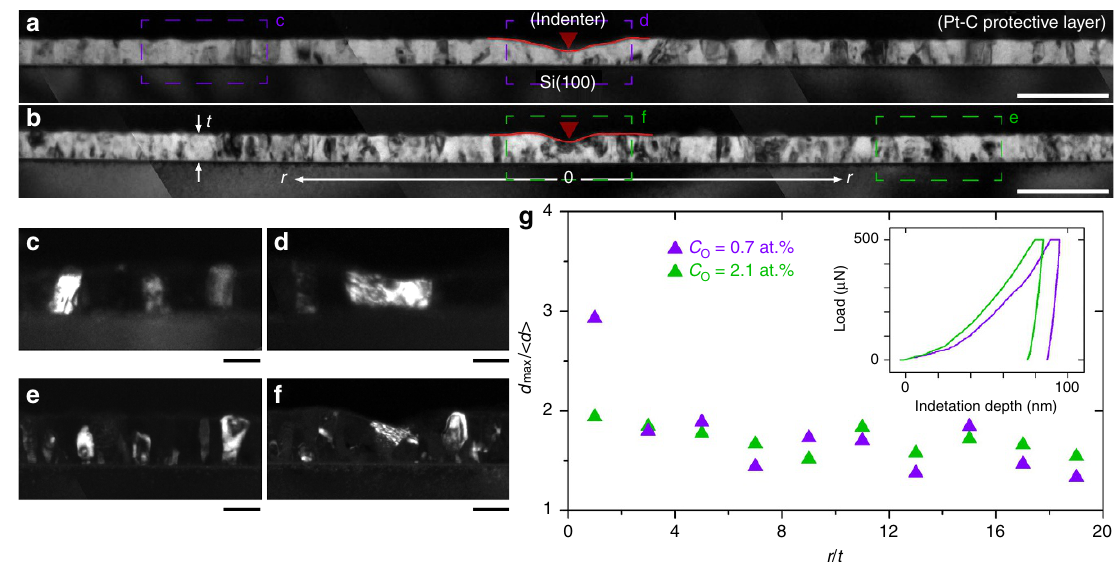
Figure 1 | Post-mortem observation of grain growth induced by nanoindentation and its suppression by impurities. ( a , b ) Bright-field TEM images of cross-sectional specimens extracted across indents in the NC Al films with global O content ( C O ) of ( a ) 0.7 and ( b ) 2.1at.%. Red lines show surface profiles of indents. Scale bars, 500nm. ( c – f ) Dark-field TEM images of individual grains ( c , e ) far from and ( d , f ) just beneath indents show occurrence and suppression of grain growth in the film with ( c , d ) low and ( e , f ) high C O , respectively. The images correspond to the outlined boxes in ( a , b ). Scale bars, 100nm. ( g ) Quantification of mechanical grain growth. The maximum grain size ( d max ) in each lateral bin normalized by averaged grain size of the film ( h d i ) is plotted versus the distance to indent ( r ) normalized by film thickness ( t ). Bin size is 2 t . Inset: indentation load-depth curves of the two